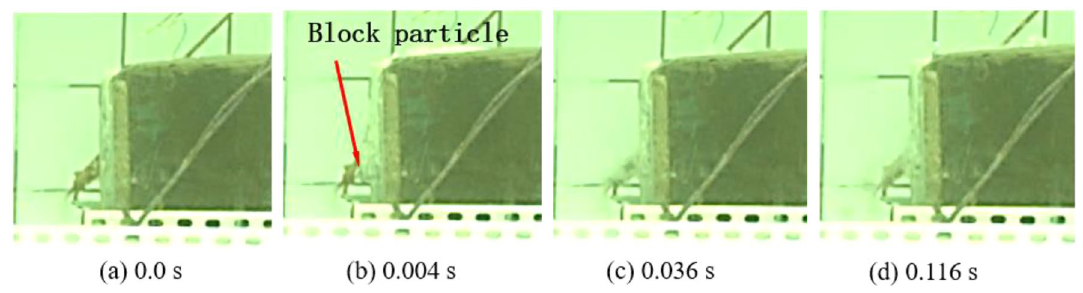
Figure 6. The motion of blocks under a charge of 0.6